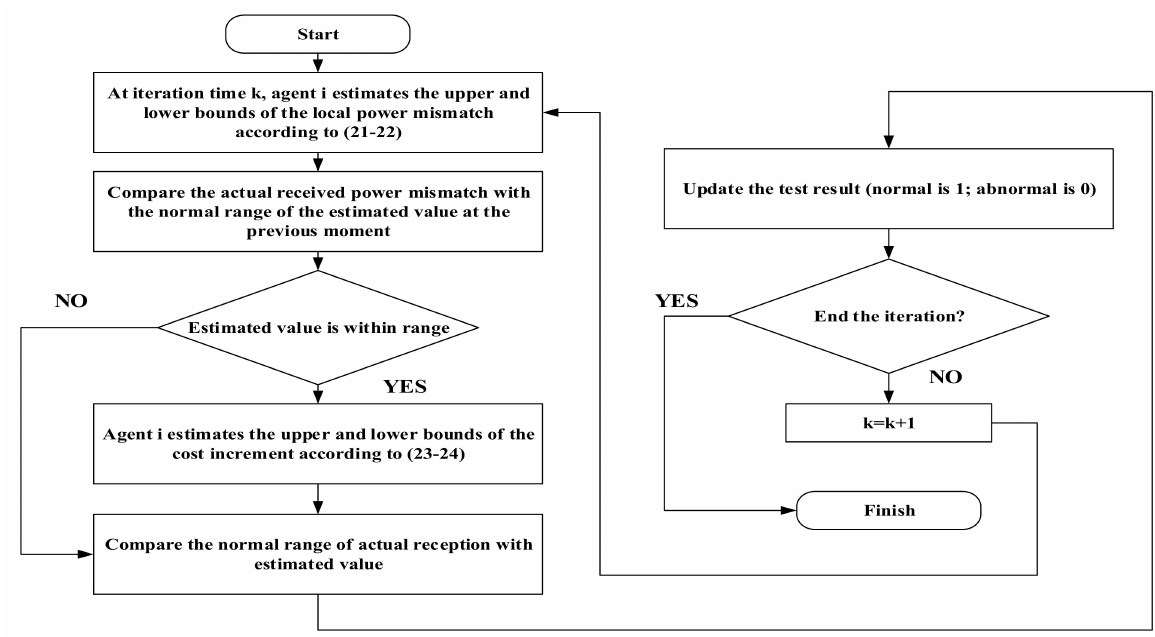
Figure 6. The flow chart of attack detection